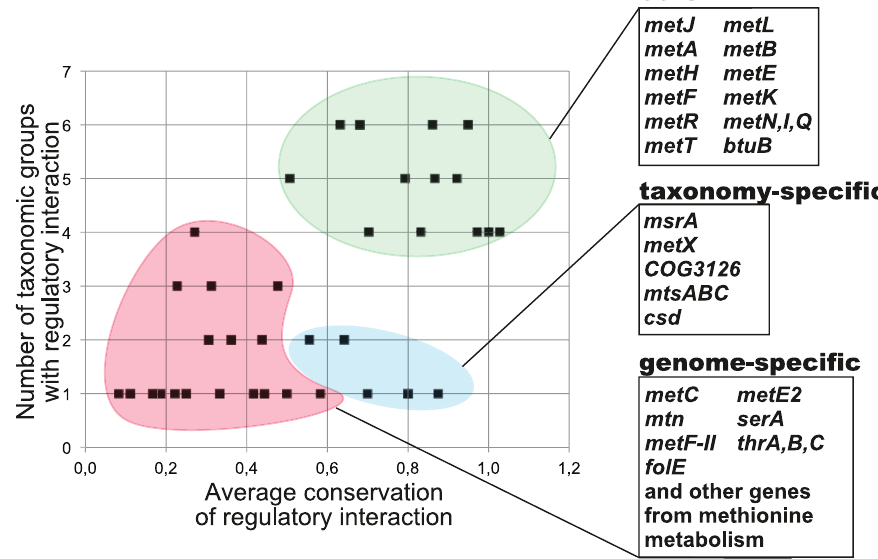
Figure 2. Conservation of regulatory interactions in the reconstructed MetJ regulons. The core regulon, taxon- and genome-specific regulon members are highlighted and listed along with their average conservation scores and functional annotations in Table S2.